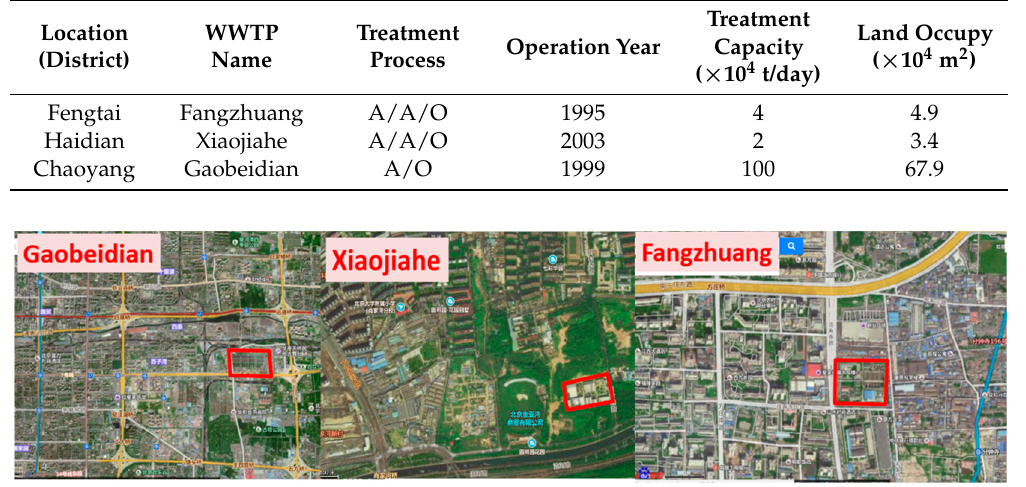
Table 3. Information of WWTPs in Beijing.